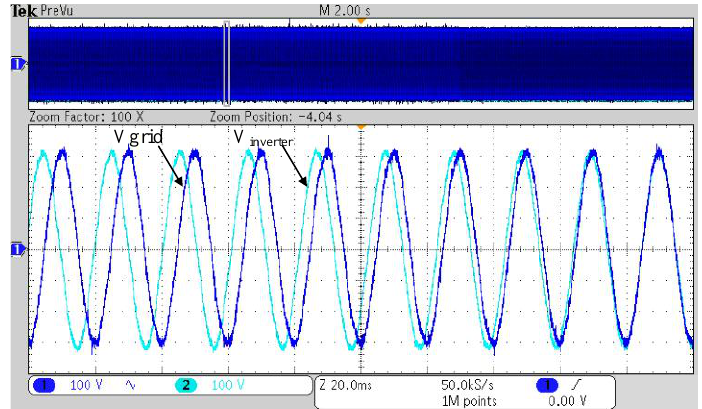
Figure 26. Dynamic synchronization process of renewable energy